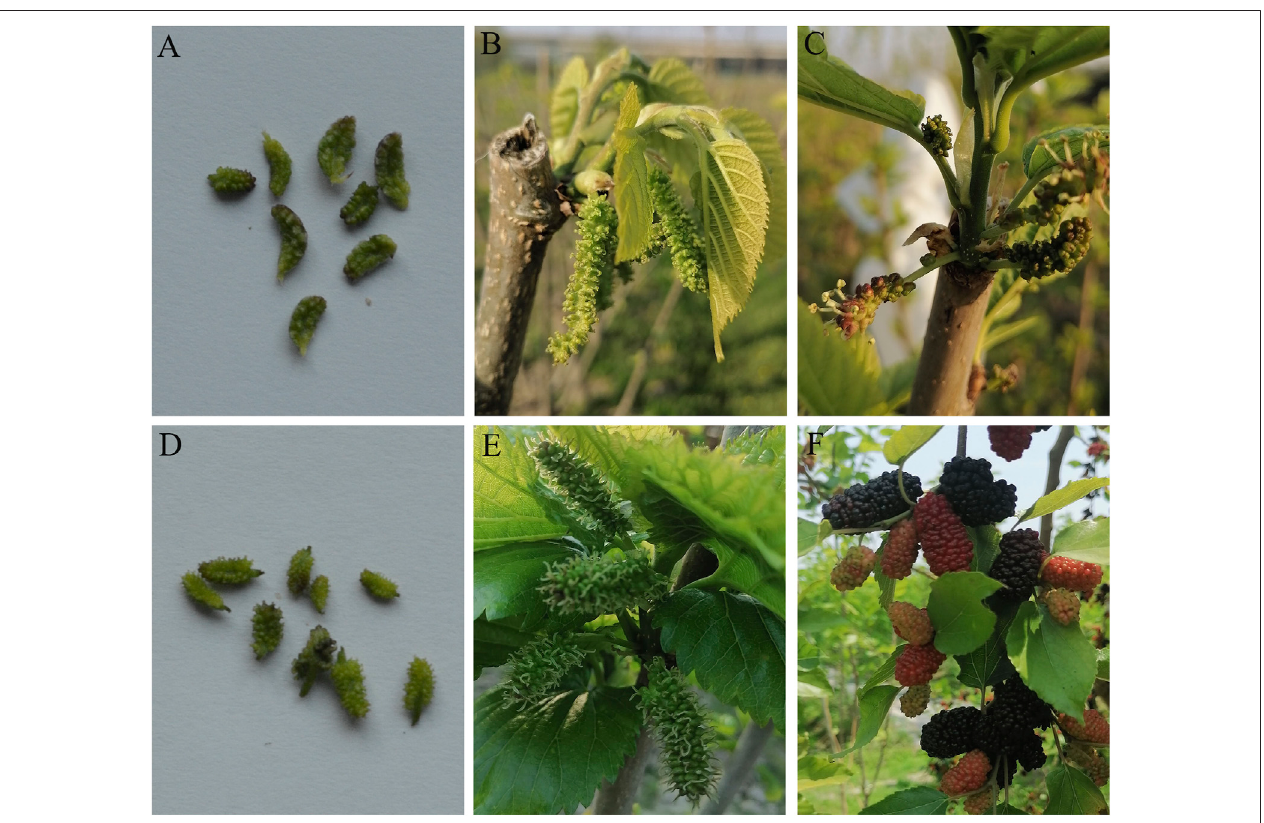
FIGURE 1 | Phenotypes of the staminate fl owers (SFs) and pistillate fl owers (PFs) of mulberry at differential development stages. (A) SFs of mulberry at the early fl owering stage. (B) Expanded SFs with stamens. (C) Mature SFs whose anthers naturally crack and pollen have wind-aided dispersal. (D) PFs of mulberry at the early fl owering stage. (E) Expanded PFs with stigma waiting for pollination will become small fruits. (F) Red or purple